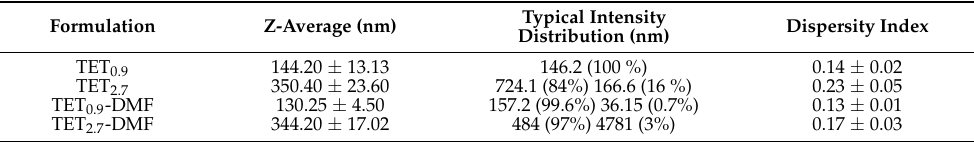
Table 2. Dimensional distribution parameters of transethosomes, as determined by